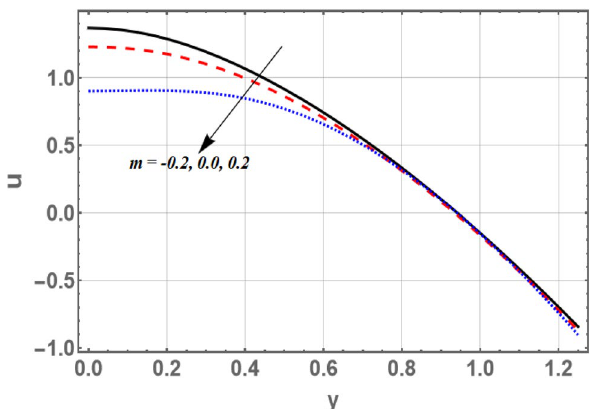
Figure 4. Graph of axial velocity u for different values of m .